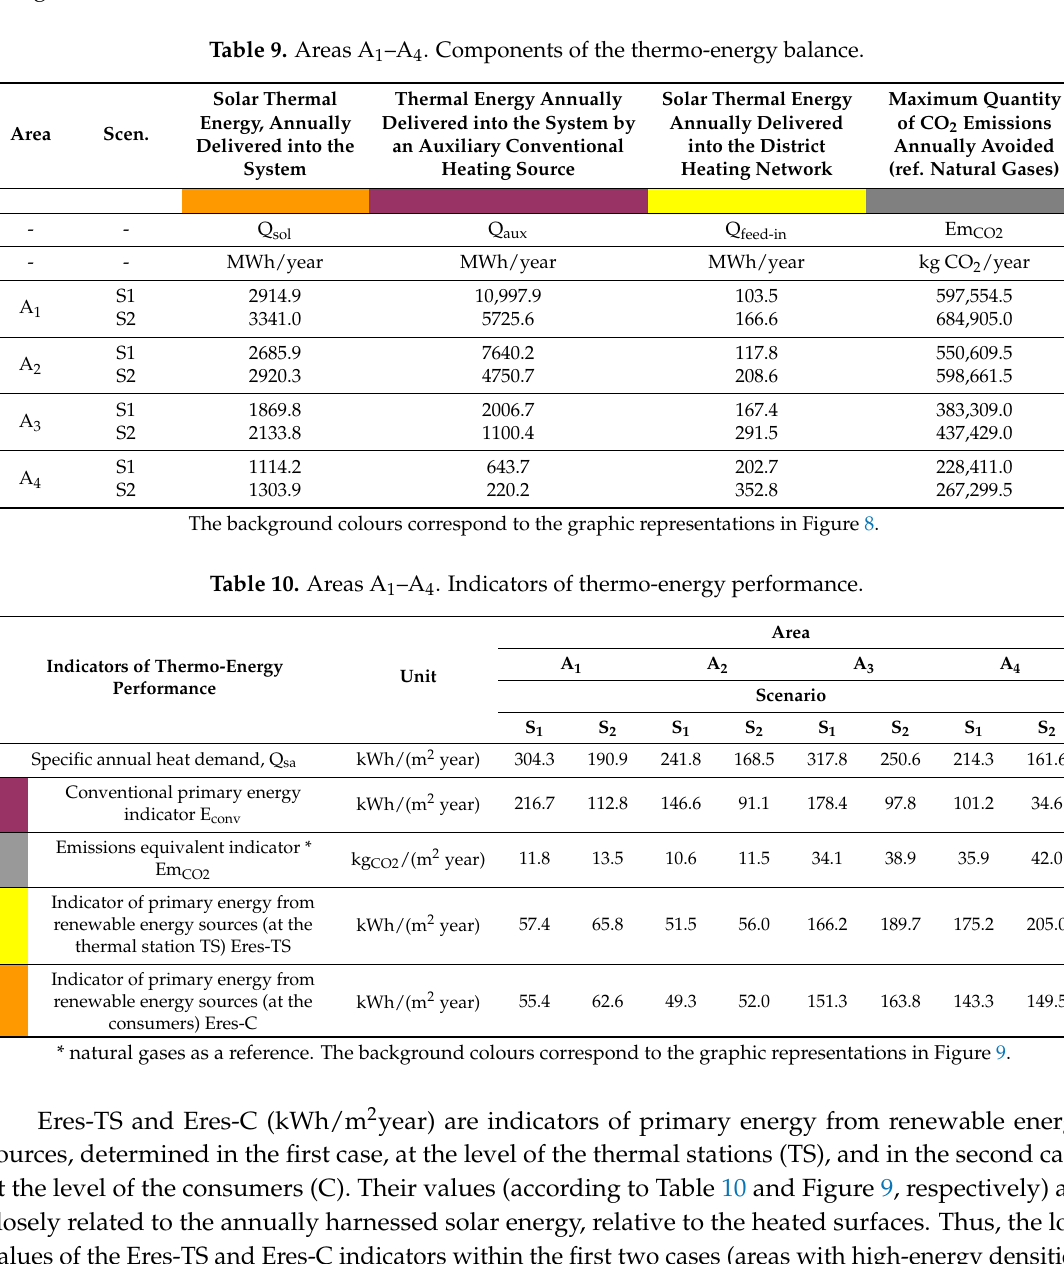
Table 9. Areas A 1 –A 4 . Components of the thermo-energy balance.